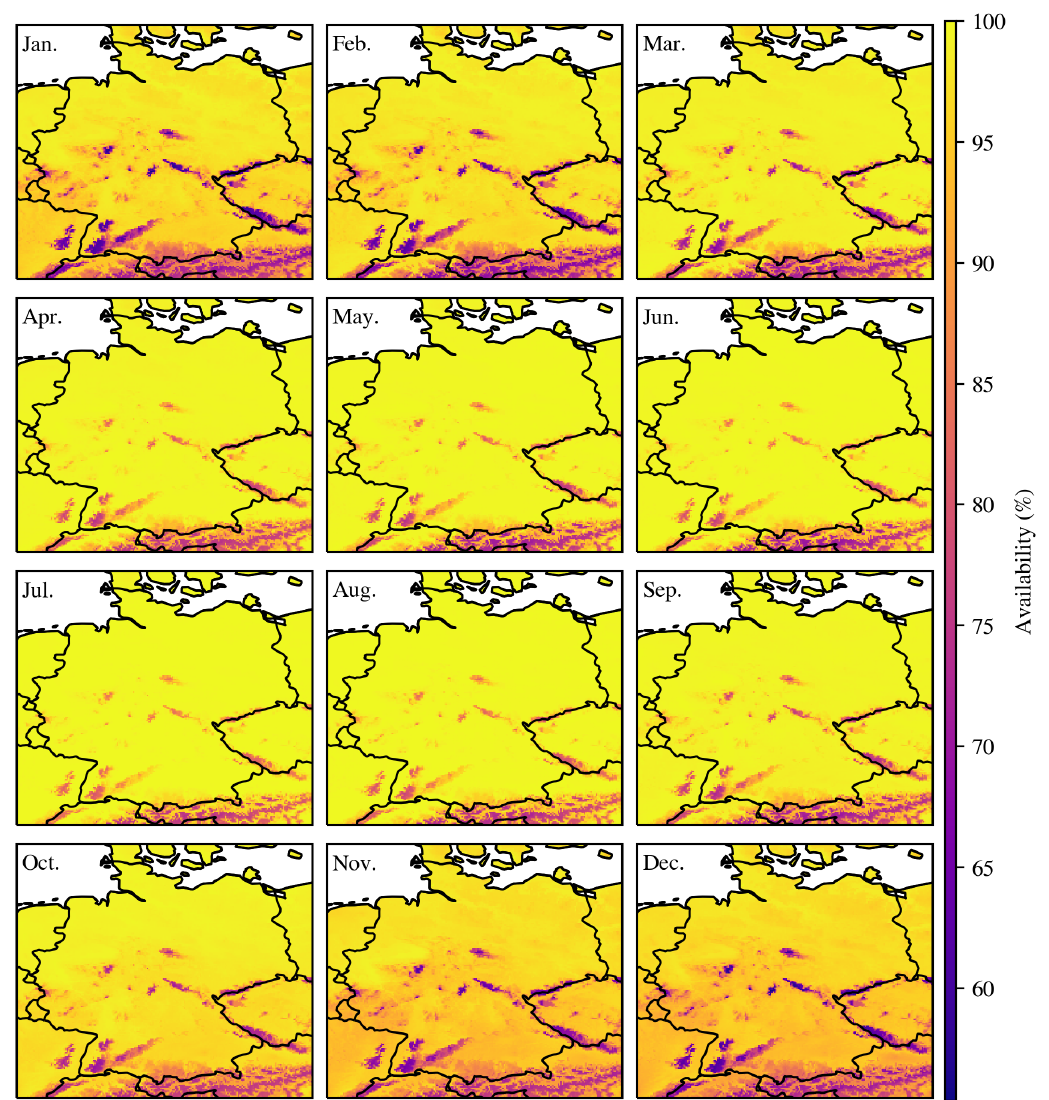
Figure 8. Monthly maps of estimated availability based on CBA ≤ 100m frequency (2006–2017) and assumed 10-min availability threshold of 80% at measurement heights of 130m and